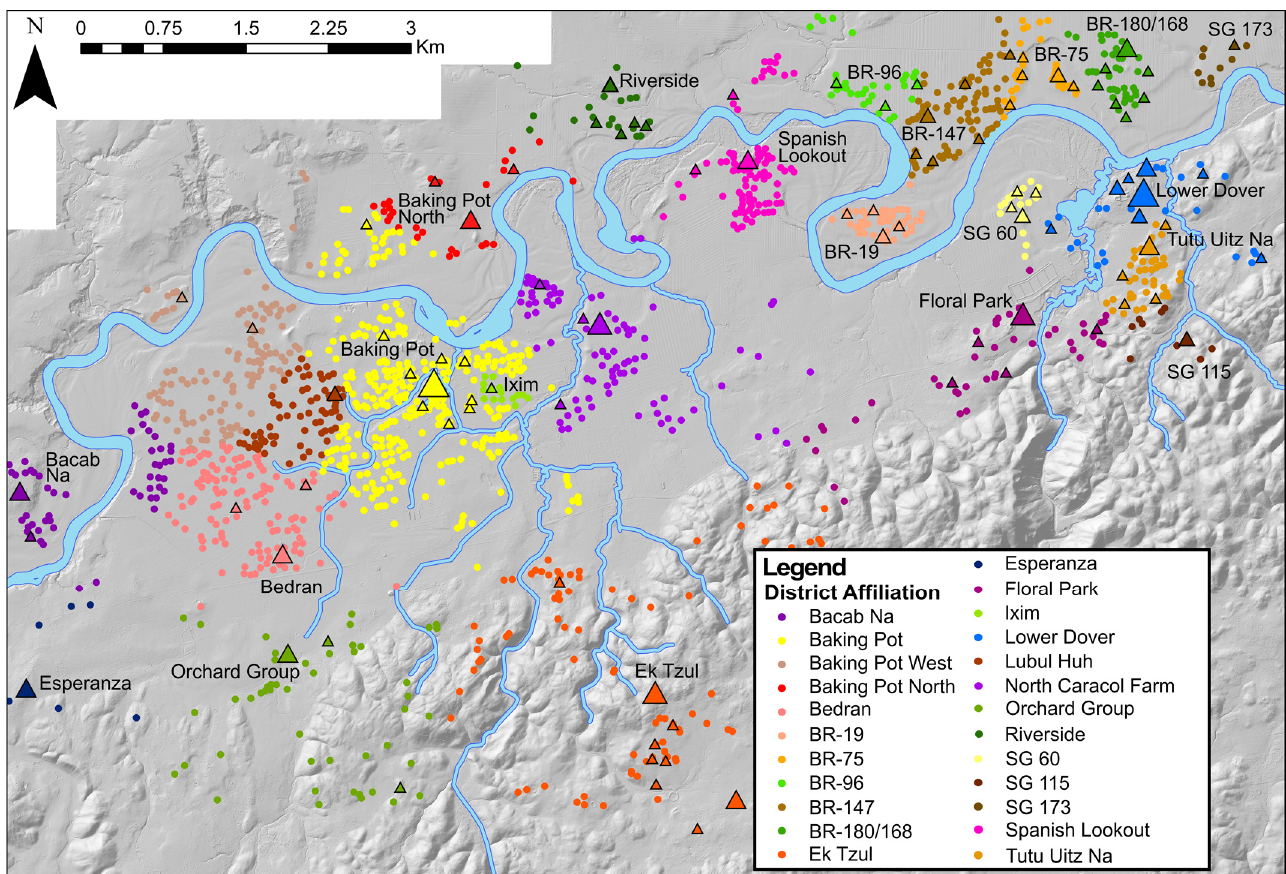
Figure 7. Xtent Model of Baking Pot and Lower Dover showing modeled labor catchments at the intermediate elite/district scale.